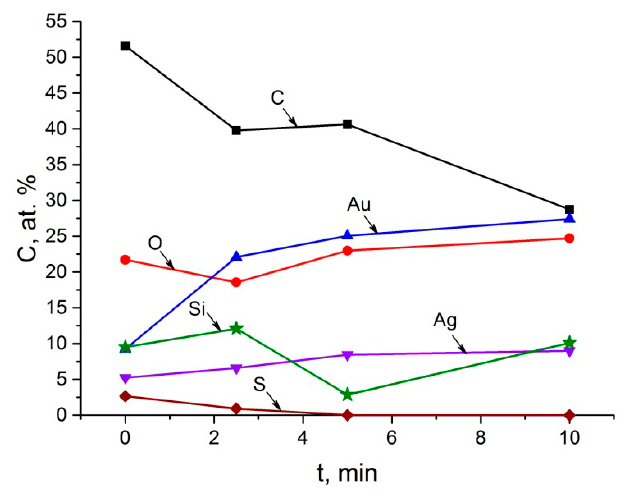
Figure 4. Change of the elements content in the course of surface etching with Ar + according to the analysis of XPS survey spectra. Sample P-5706.